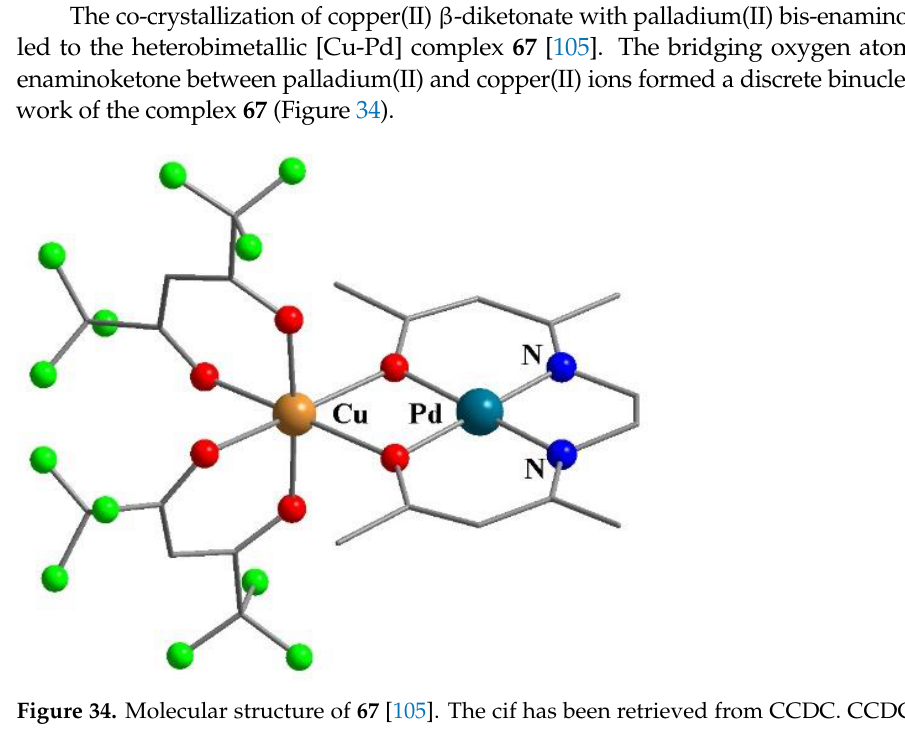
Figure 33. Molecular structure of 65 , 66 (dik = hfac) [103,104]. Hydrogen atoms have been omitted, some ligand groups are transparent for clarity. The cif has been retrieved from CCDC.